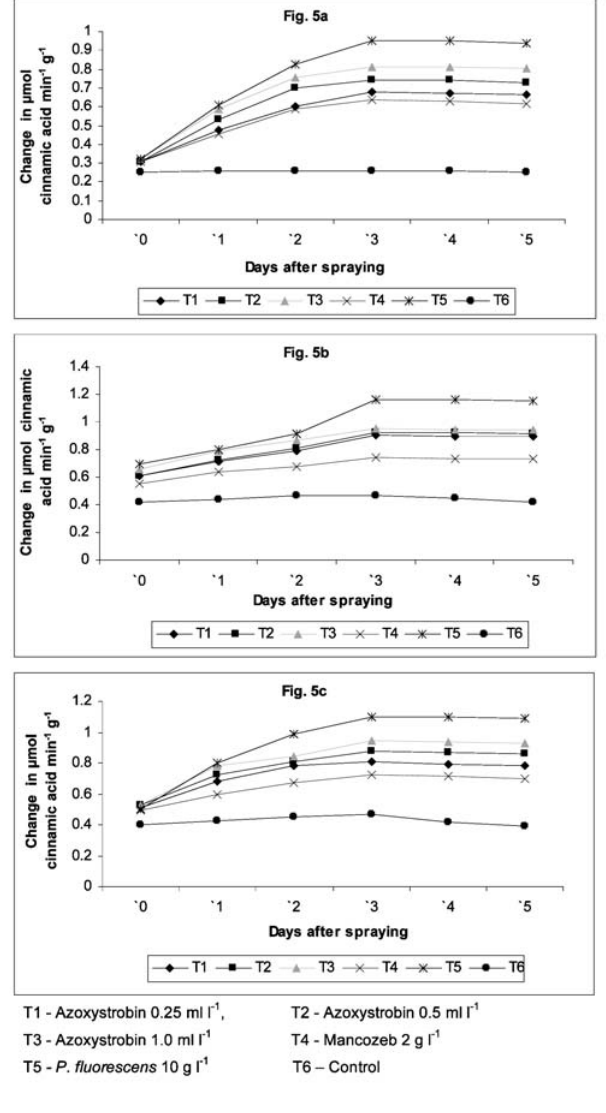
Fig. 5. Changes in PAL activity in cucumber plants: 5a, uninoculated and treated with azoxystrobin and Pseudo- monas fl uorescens; 5b, challenge-inoculation of downy mildew pathogen; 5c, challenge-inoculation of powdery mildew